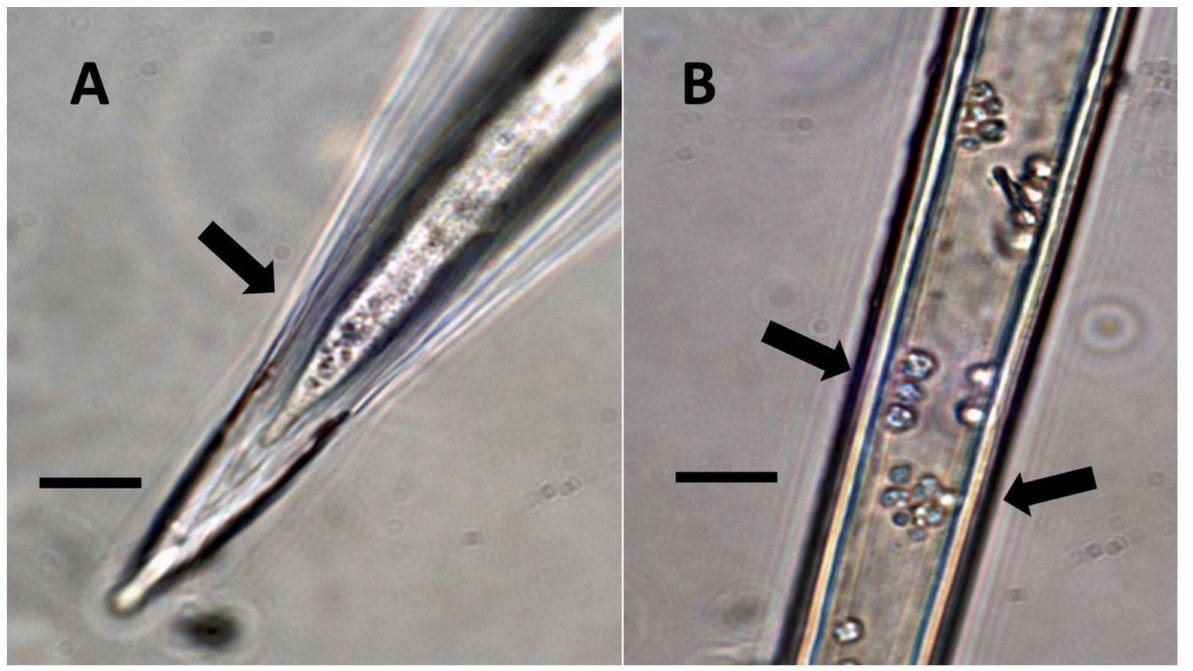
Figure 5. Non-pitted trichomes of Phragmites australis showing internal bacteria. ( A ) Ligule trichome stained with iron sulfate to show nitric oxide (brown color) around bacteria (arrow) in hair tip (Bar = 10 µ m). ( B ) Ligule trichome stained with ammonium molybdate to show ethylene (blue-purple color) around bacteria (arrows) in hair (Bar = 10 µ m).